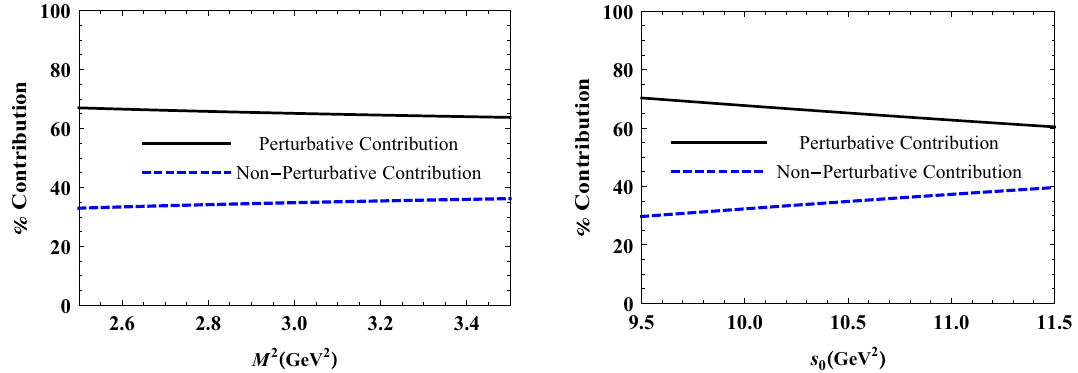
Fig. 8 The perturbative and nonperturbative components of (cid:6) QCD ( M 2 , s 0 ) AV . Left: as functions of M 2 at s 0 = 10 . 5 GeV 2 , right: as functions of s 0 at the central value of the Borel parameter M 2 = 3 GeV 2